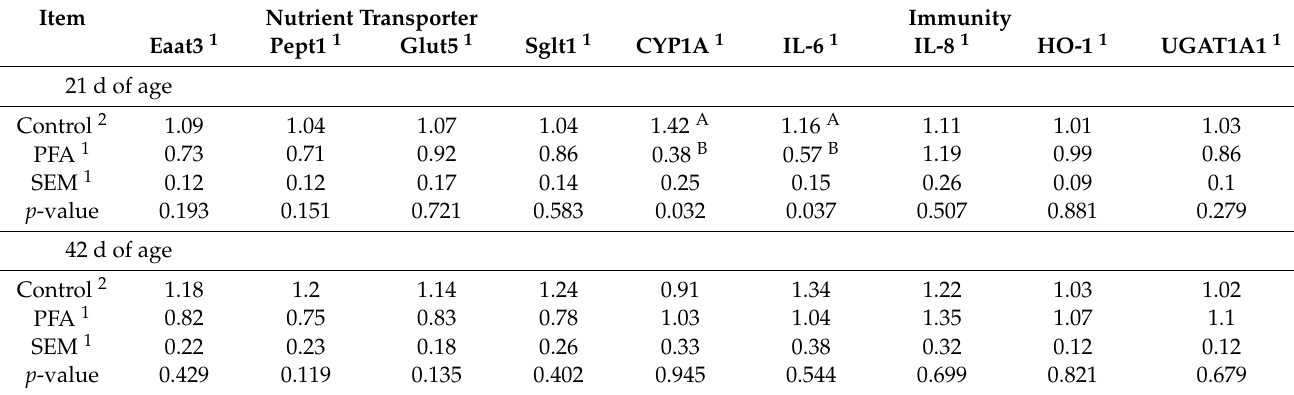
Table 6. Effect of PFA on the gene expression of nutrient transporters and immune parameters of broilers.